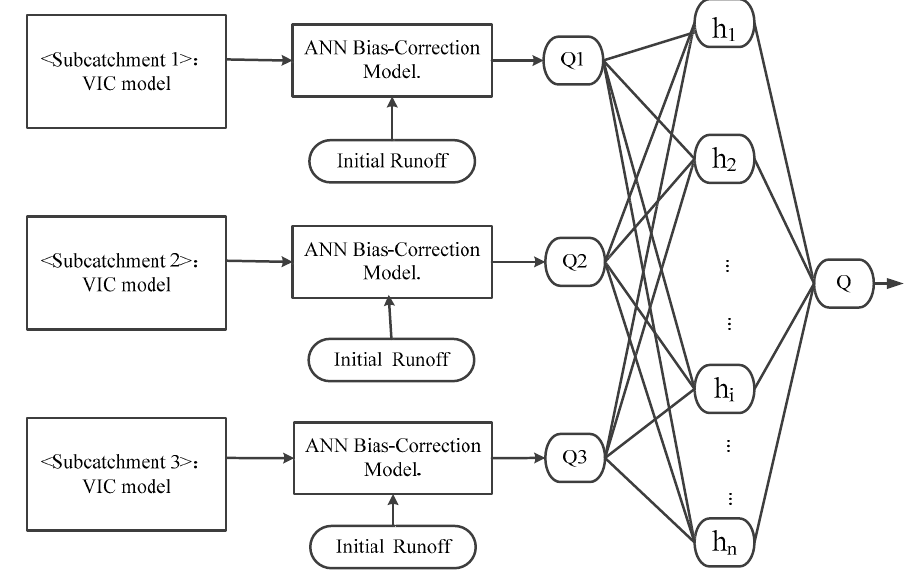
Figure 1. Flowchart of the variable infiltration capacity (VIC) and ANN model.